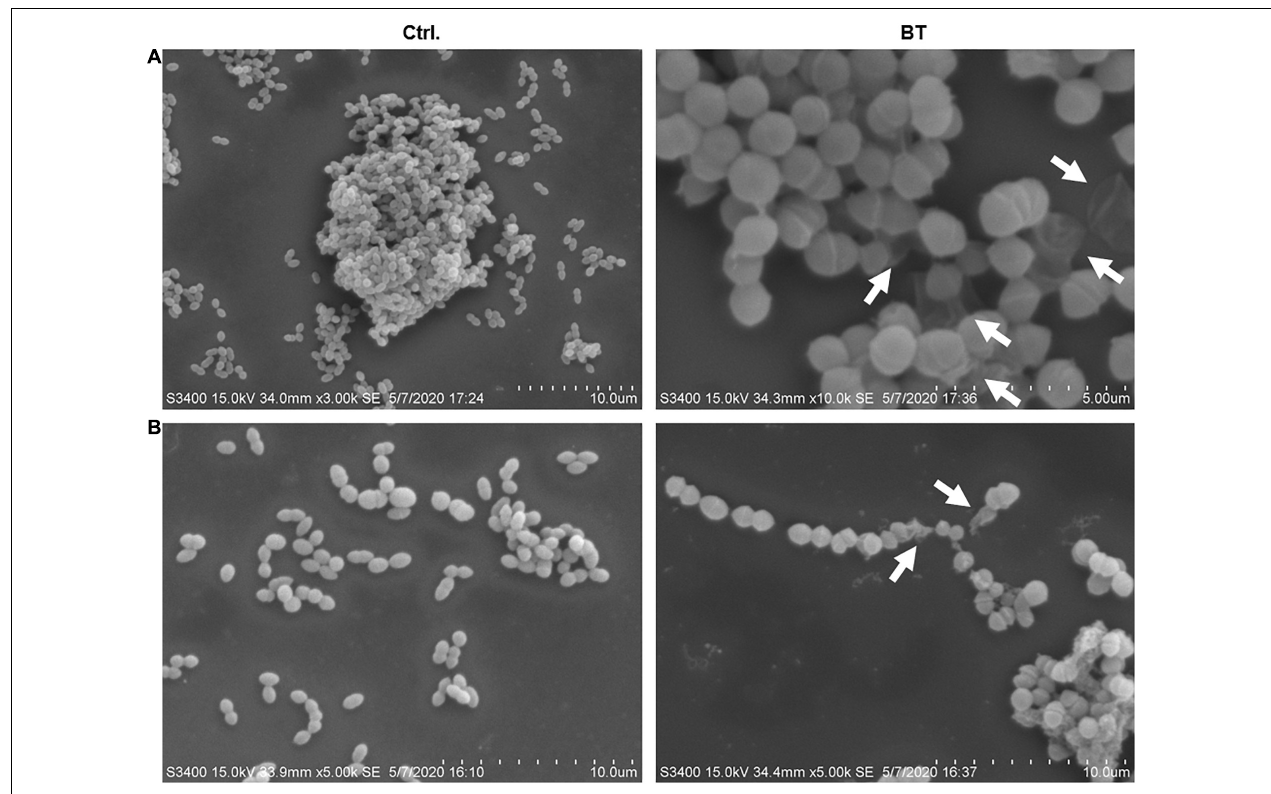
FIGURE 3 | SEM images of BT treatment of (A) Enterococcus faecalis ATCC 29212 and (B) VAN-resistant E. faecium U101; 5 × MIC of BT was used for 1 h treatment, followed by fixation with 2% glutaraldehyde. The arrows indicate cell membrane